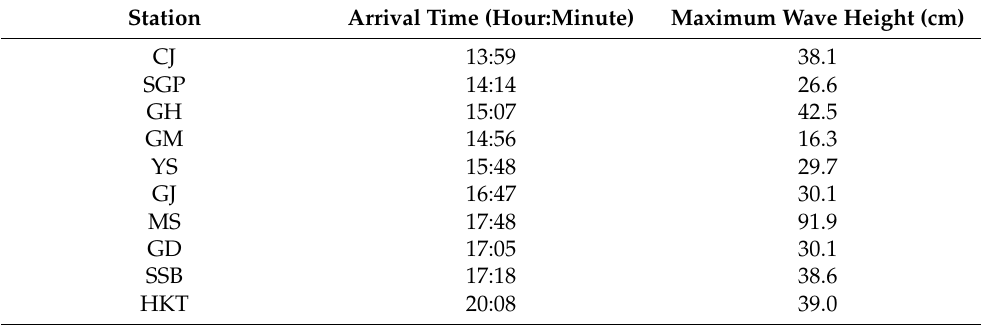
Figure 3. Variations of ( a ) atmospheric pressure (hPa) and ( b ) sea levels (cm), which were high-pass-filtered with a cutoff period of 180 min. ( c ) Arrival times (hour:minute) of atmospheric pressure disturbances and ( d ) the long ocean waves (meteotsunami) along the Korea Strait on 7 April 2019. The contour intervals are 30 min. The dashed green contour lines in ( c ) and ( d ) are the extrapolated locations of atmospheric pressure disturbance and long ocean wave, respectively, based on the patterns of nearby observation data. Table 2. Arrival times and maximum wave heights of long ocean waves at the tide gauge stations in the Korea Strait.